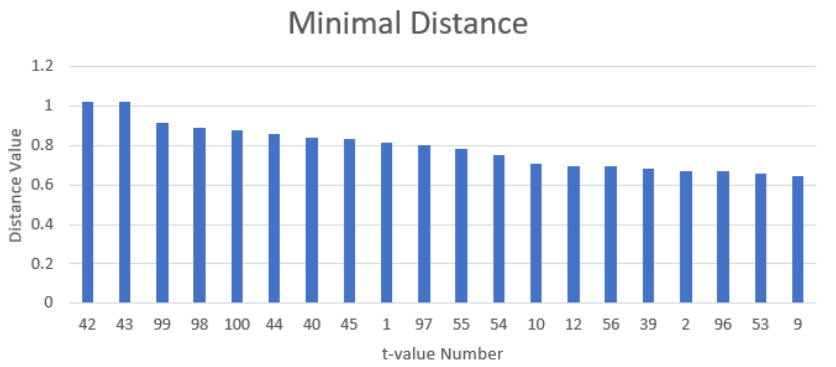
Figure 7. The top 30 minimal distance values in descending order.